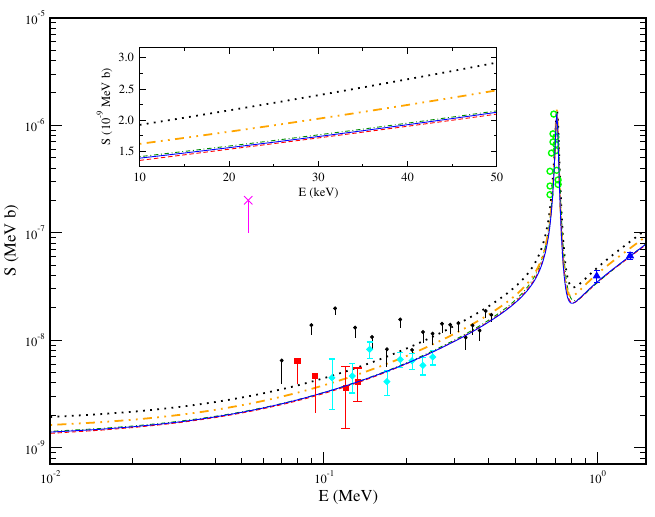
Figure 1. The total astrophysical S -factor, as calculated in Ref. [2], in the energy range 10 keV-1.5 MeV. The experimental data have been taken from Ref. [7–13]. In the insert, the tail of the S -factor in the energy range 10-50 keV. The dotted (black), dashed (red), dot-dashed (green), dot-dot-dashed (orange) and solid (blue) lines correspond to the results obtained with the V H , V T , V M , V D and V G potentials,